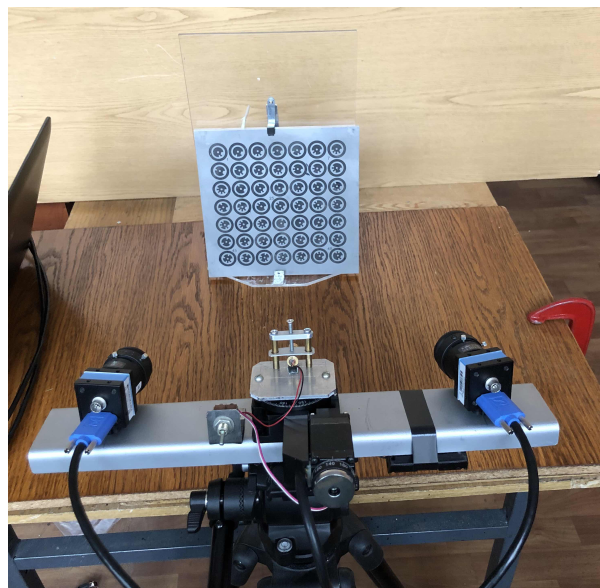
Figure 4. Calibration in single optical media (air) environment